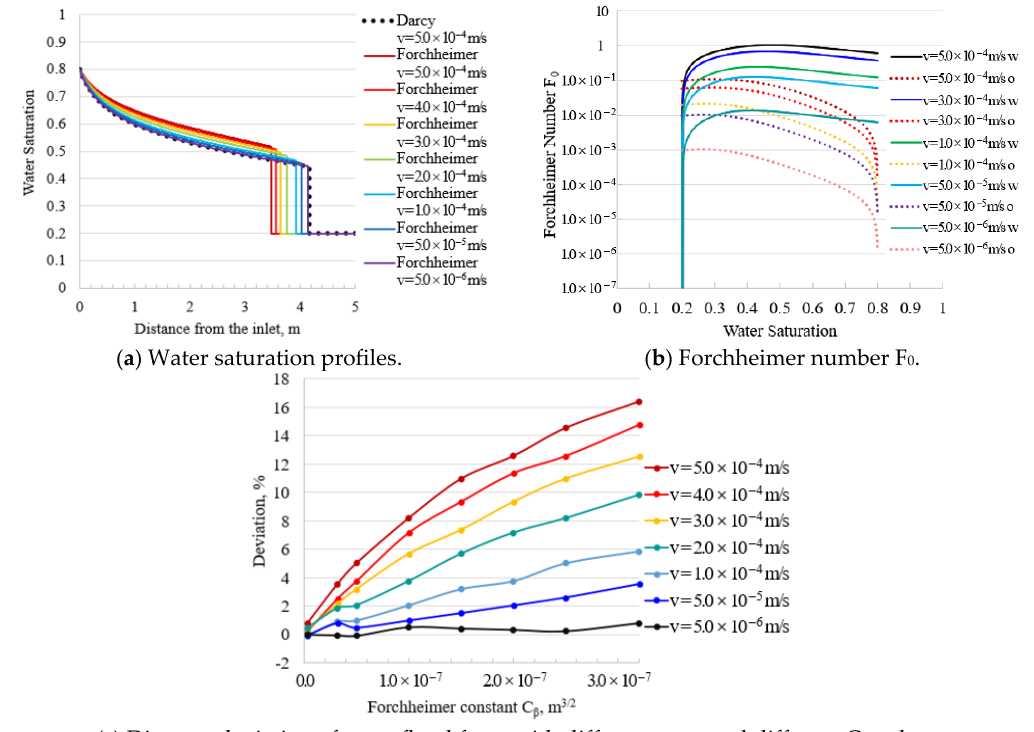
Figure 8. Comparison of Darcy flow versus Forchheimer flow at different flow rates.